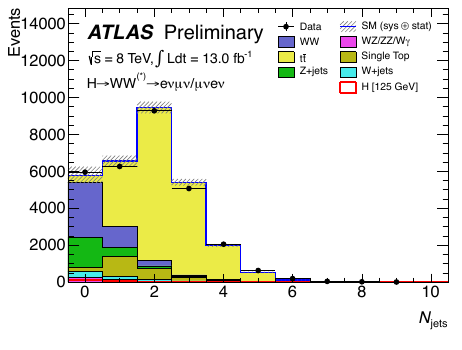
Figure 1. Multiplicity of jets for events satisfying the pre- selection criteria [5] described in the text. The hashed area in- dicates the total uncertainty on the background prediction. The WW and top backgrounds are scaled to use the normalization derived from the corresponding control regions described in the